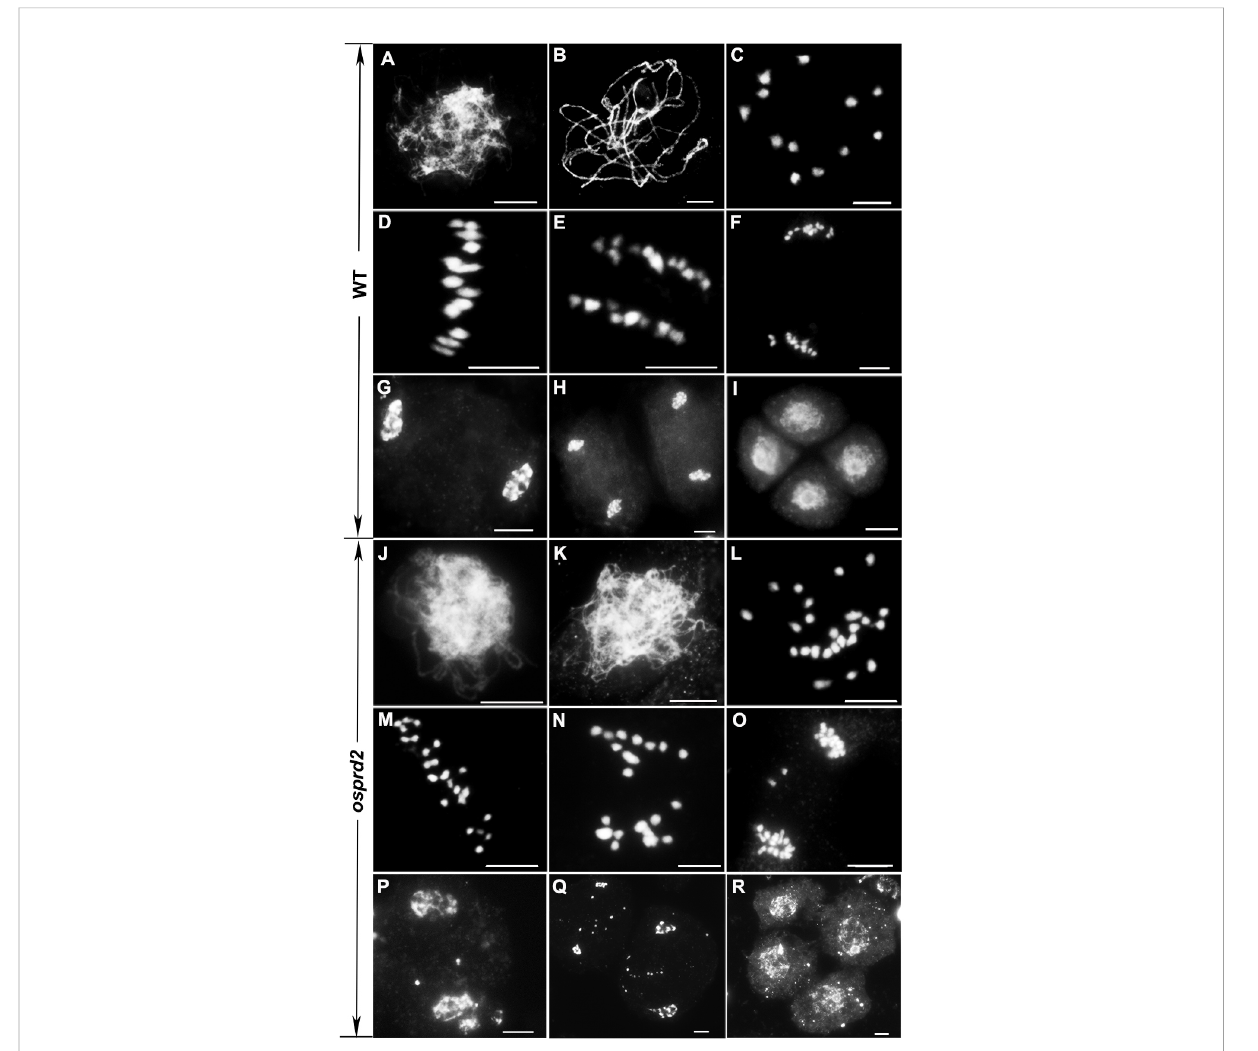
FIGURE 2 Meiotic chromosome behavior in WT and osprd2 . (A, J) leptotene, (B, K) pachytene, (C, L) diakinesis, (D, M) metaphase I, (E, K) anaphase I, (F, O) telophase I, (G, P) prophase II, (H, Q) telophase II, (I, R) tetrad. (A-I) are wild type; (J-R) are osprd2 mutant. Bar=5 m